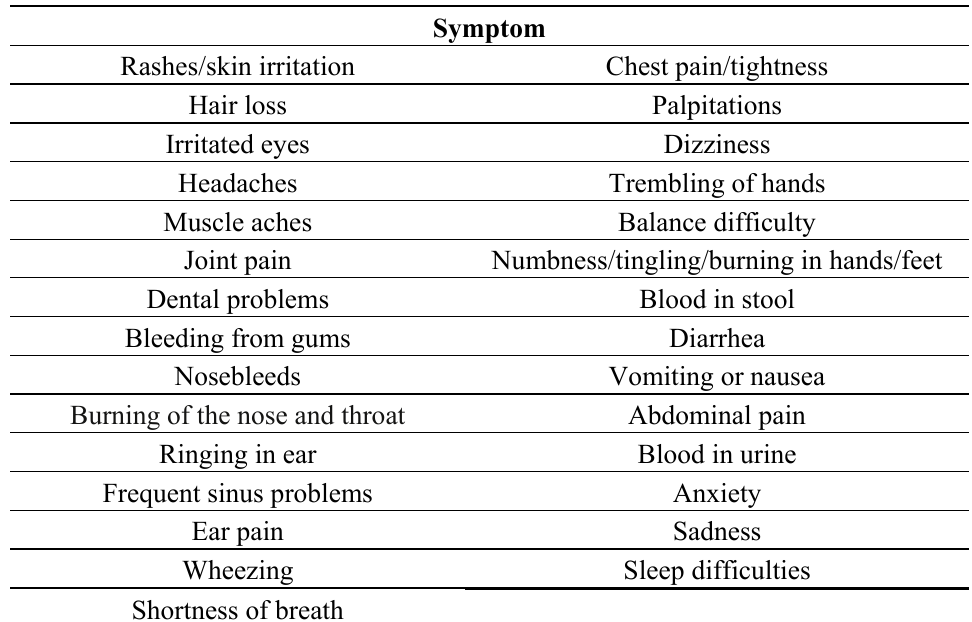
Table 1. List of Symptoms in Survey Questionnaire.